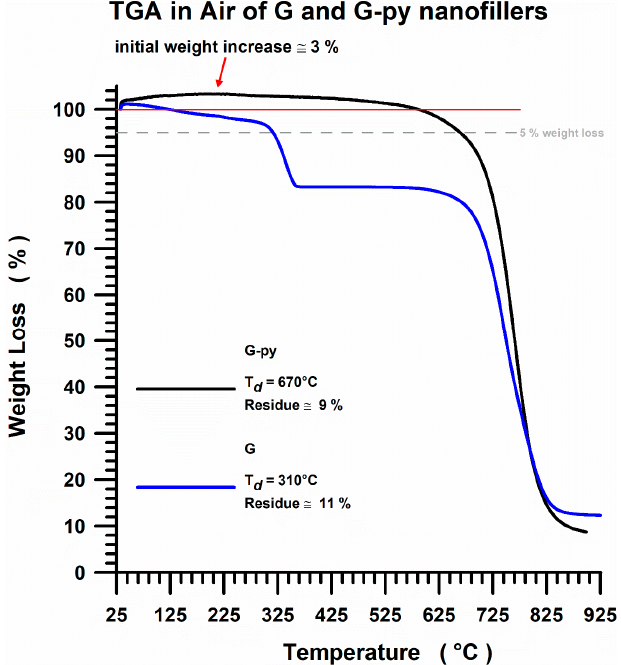
Figure 14. TGA curves in air of G and G-py nanofillers.